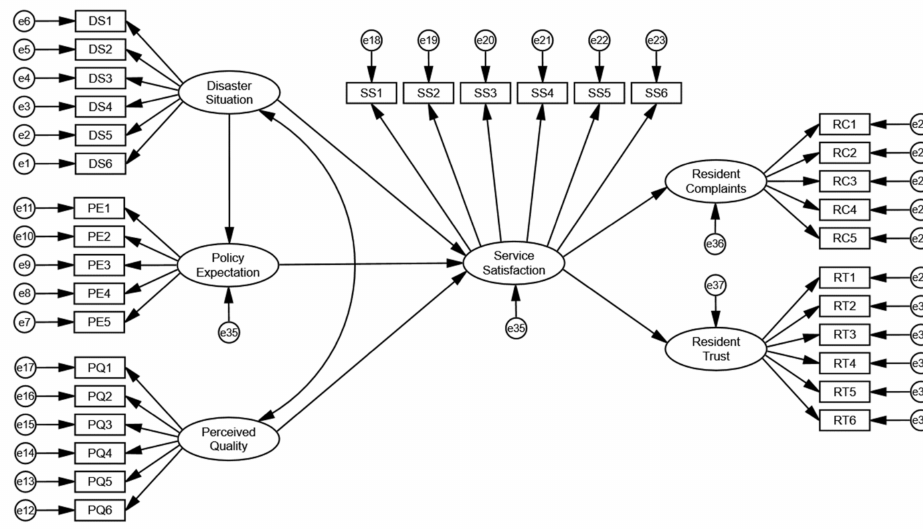
Figure 2. The construction of the structural equation